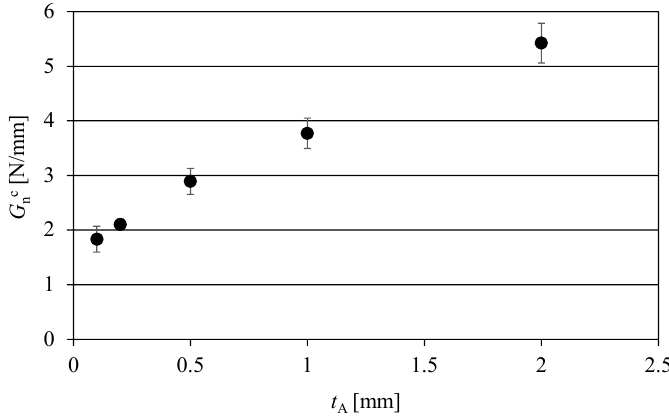
Figure 11: Average values and deviation of G n c as a function of t